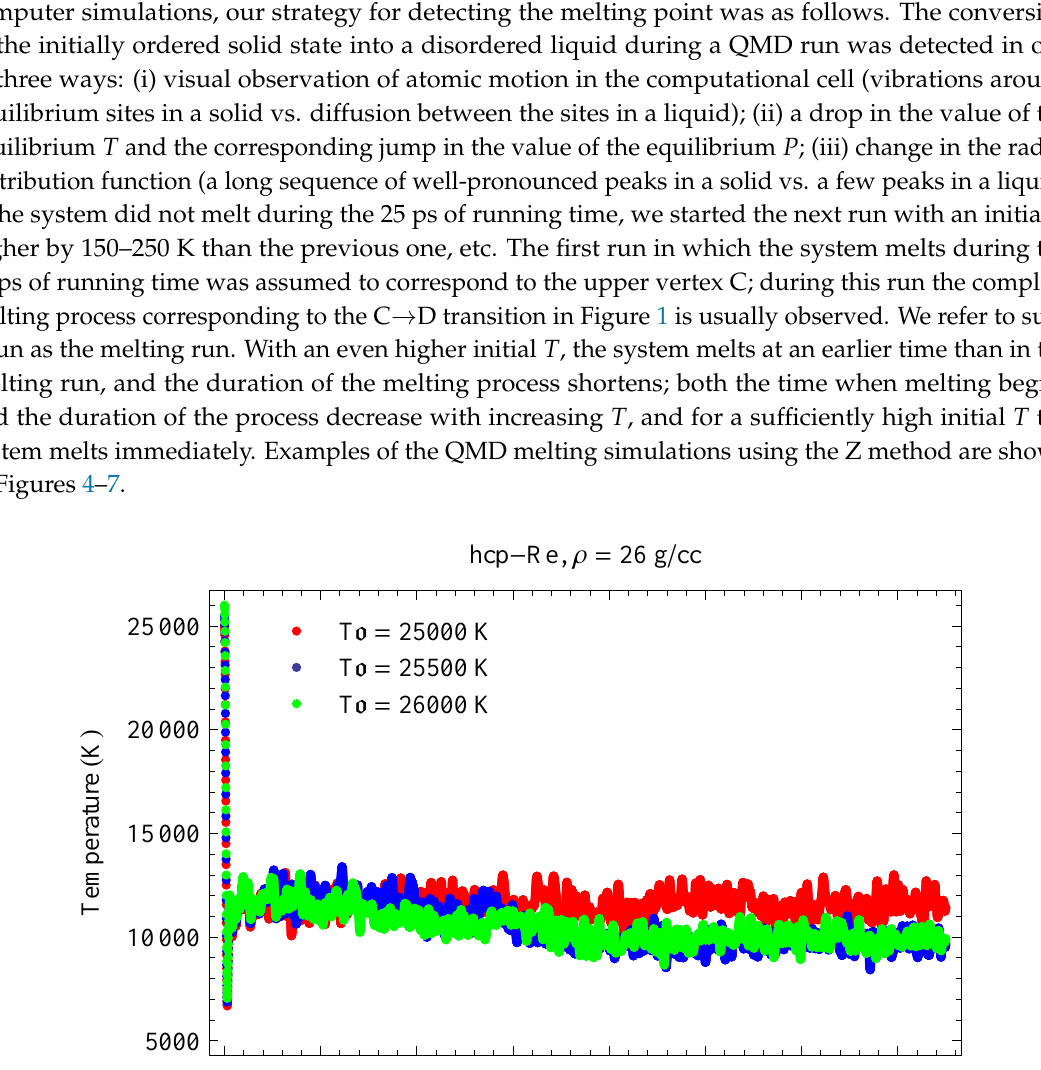
12,000 K for the superheated 12000 K for the ∼ ∼